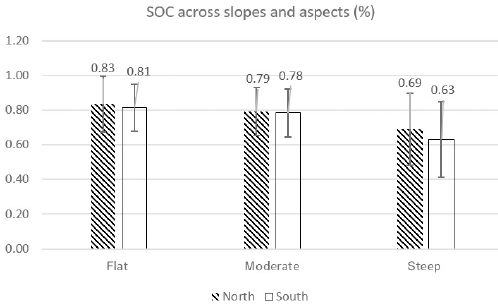
Figure 5. SOC rates according to slope and aspect in the Wadi Beja watershed, Tunisia.